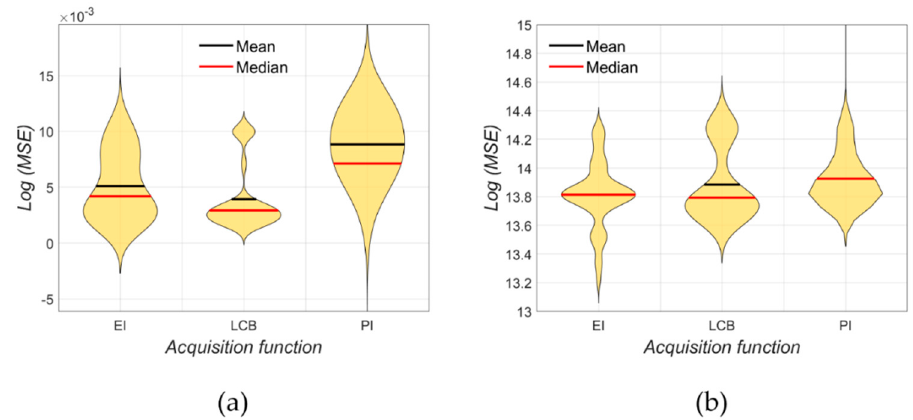
Figure 4. Violin plot of MSE values in log scale after 50 runs of BOA for each acquisition function in optimizing an ESN for ( a ) the Polish dataset, and ( b ) the Brazilian dataset.